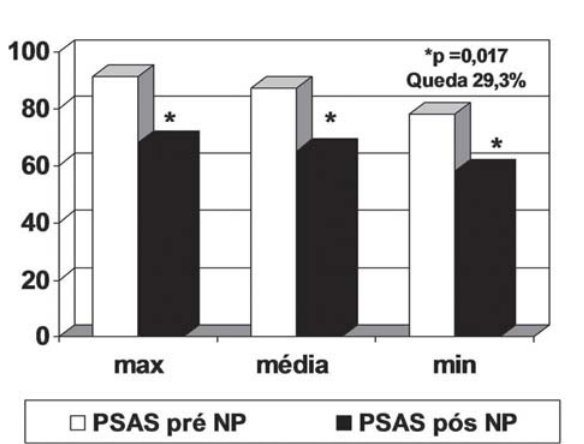
Fig.1 - Pressões arteriais sistêmicas no intra-operatório pré e pós uso de nitroprussiato de sódio